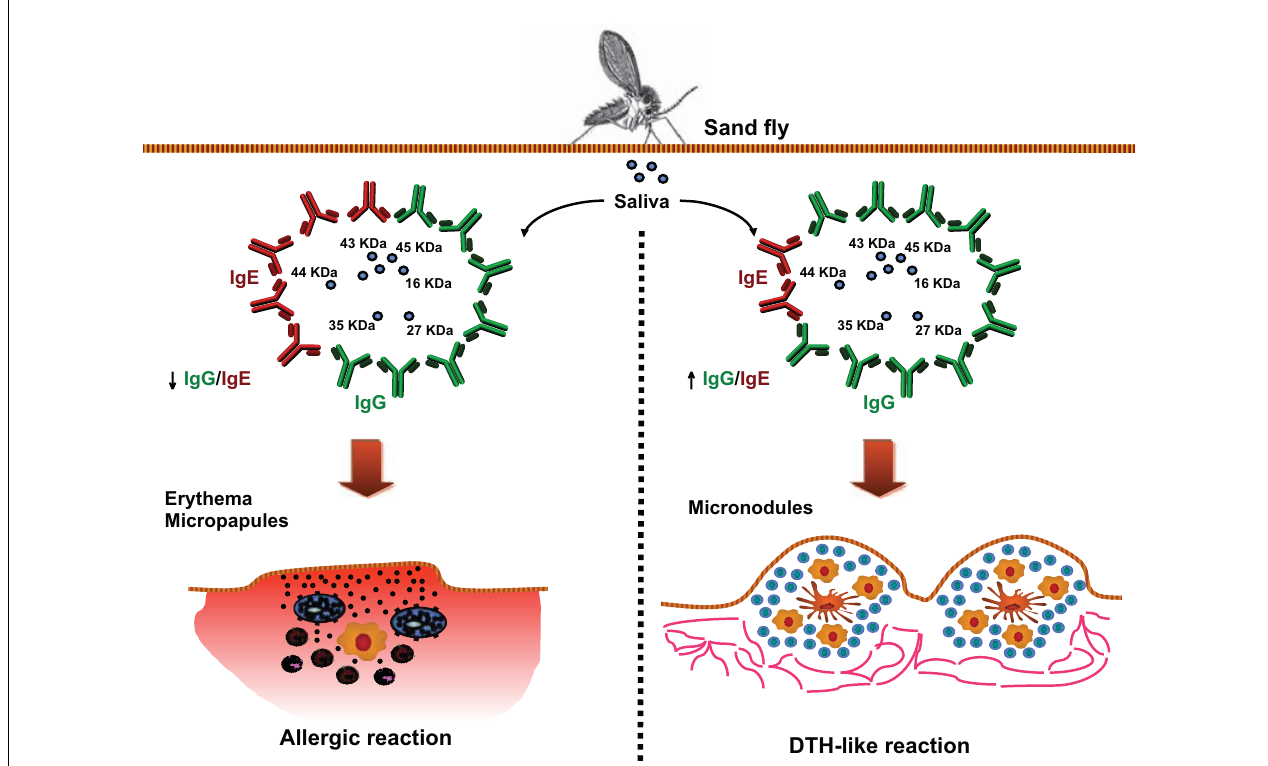
displayed high levels of IgG1, IgG4, and IgE anti-saliva and recognized several salivary gland proteins. Interestingly, volunteers who developed immediate skin reactions (left panel) presented higher IgE levels and lower IgG levels than those with delayed skin responses (right panel), as demonstrated by the IgG/IgE ratio.Whether this variability in the host responses against saliva is associated with different degree of susceptibility to Leishmania infection is still